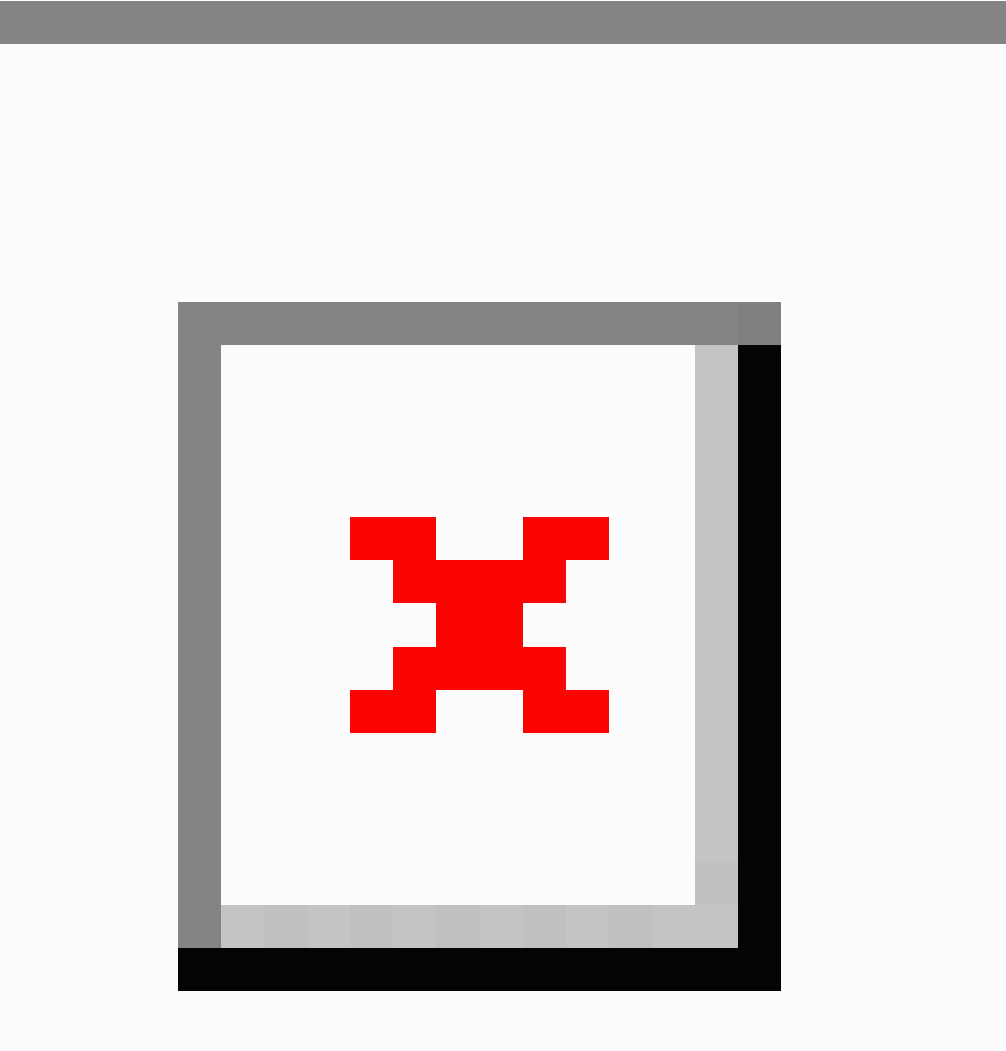
Figure 4. New player registrations per month, with academic degree. The figure shows the fluctuations in both the size and the demographics of the player population over